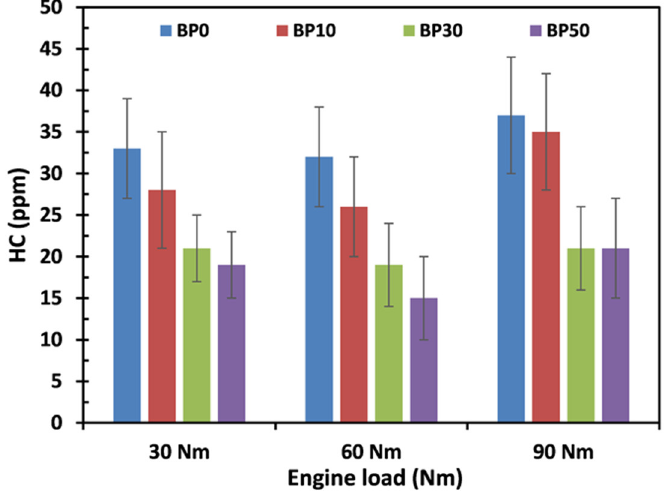
Figure 9. HC emissions for all test fuels according to various engine